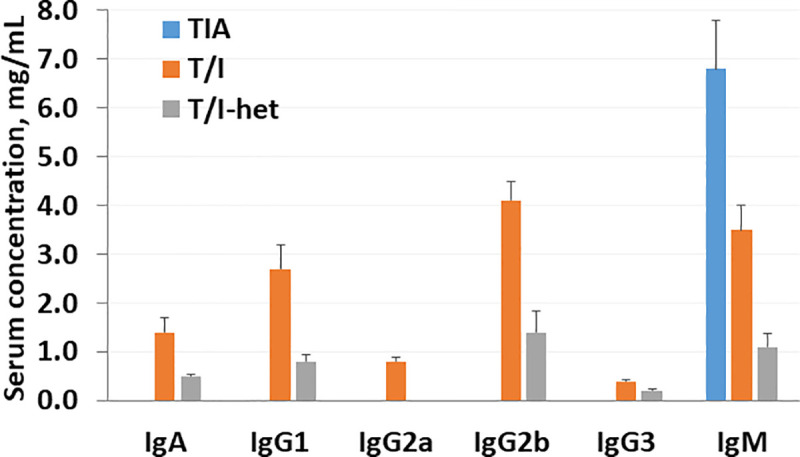
Serum immunoglobulin concentrations in TIA, T/I, and control T/Ihet mice.The serum concentration of various immunoglobulin isotypes are shown for 8–10 week old TIA (n = 17), T/I (n = 28), and control T/Ihet mice (n = 13). Values shown represent the mean ± standard error of the mean (SEM). Values obtained for TIA mice were statistically different than for T/I mice for all isotypes tested, with p values ranging from p = 0.006 for IgM to 7 x 10−12 for IgG3 (Student’s t-test).